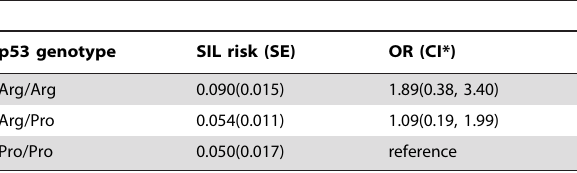
Table 4. Cumulative 2-year risk (standard errors) of SIL by p53 genotype: results from Model 2.